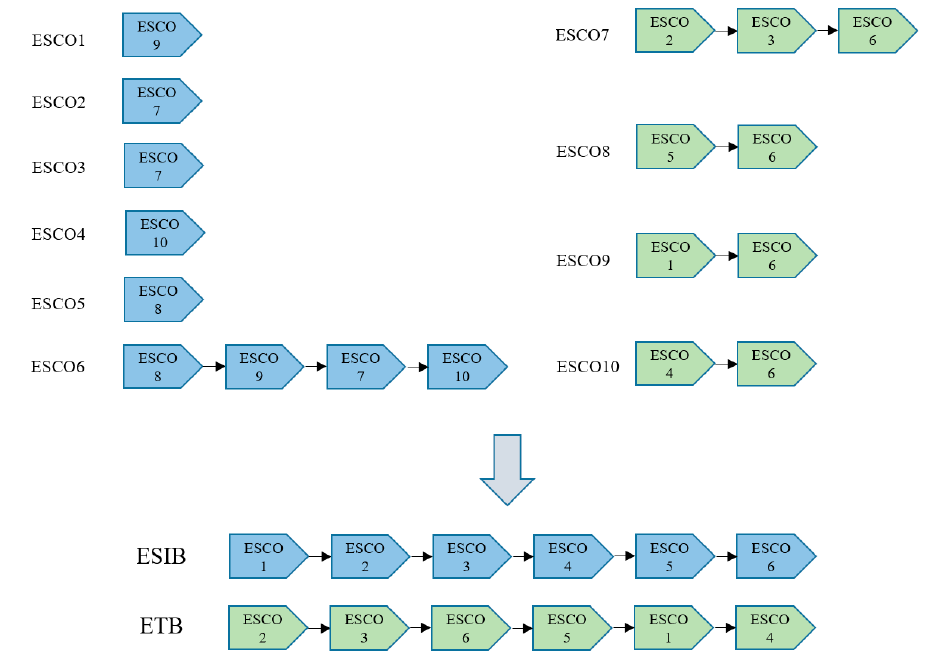
Figure 8. The final matched pairs and the formation of ETB.